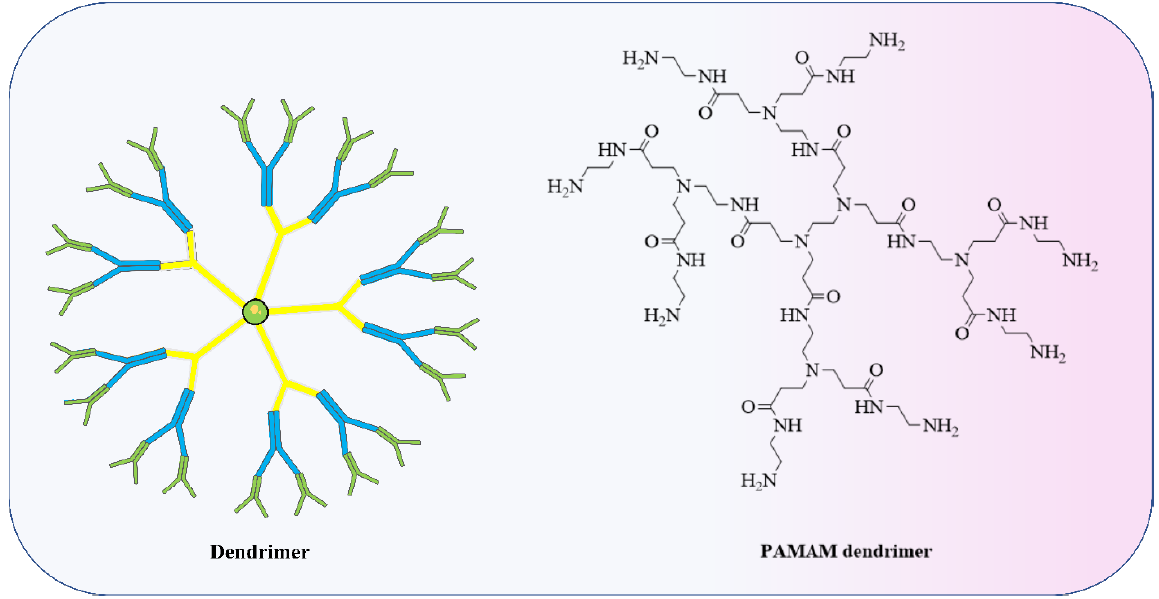
Figure 4. Dendrimers are specific polymeric structures made up of a set number of molecules arranged around a central PAMAM, poly(amidoamine) used to form LNP.